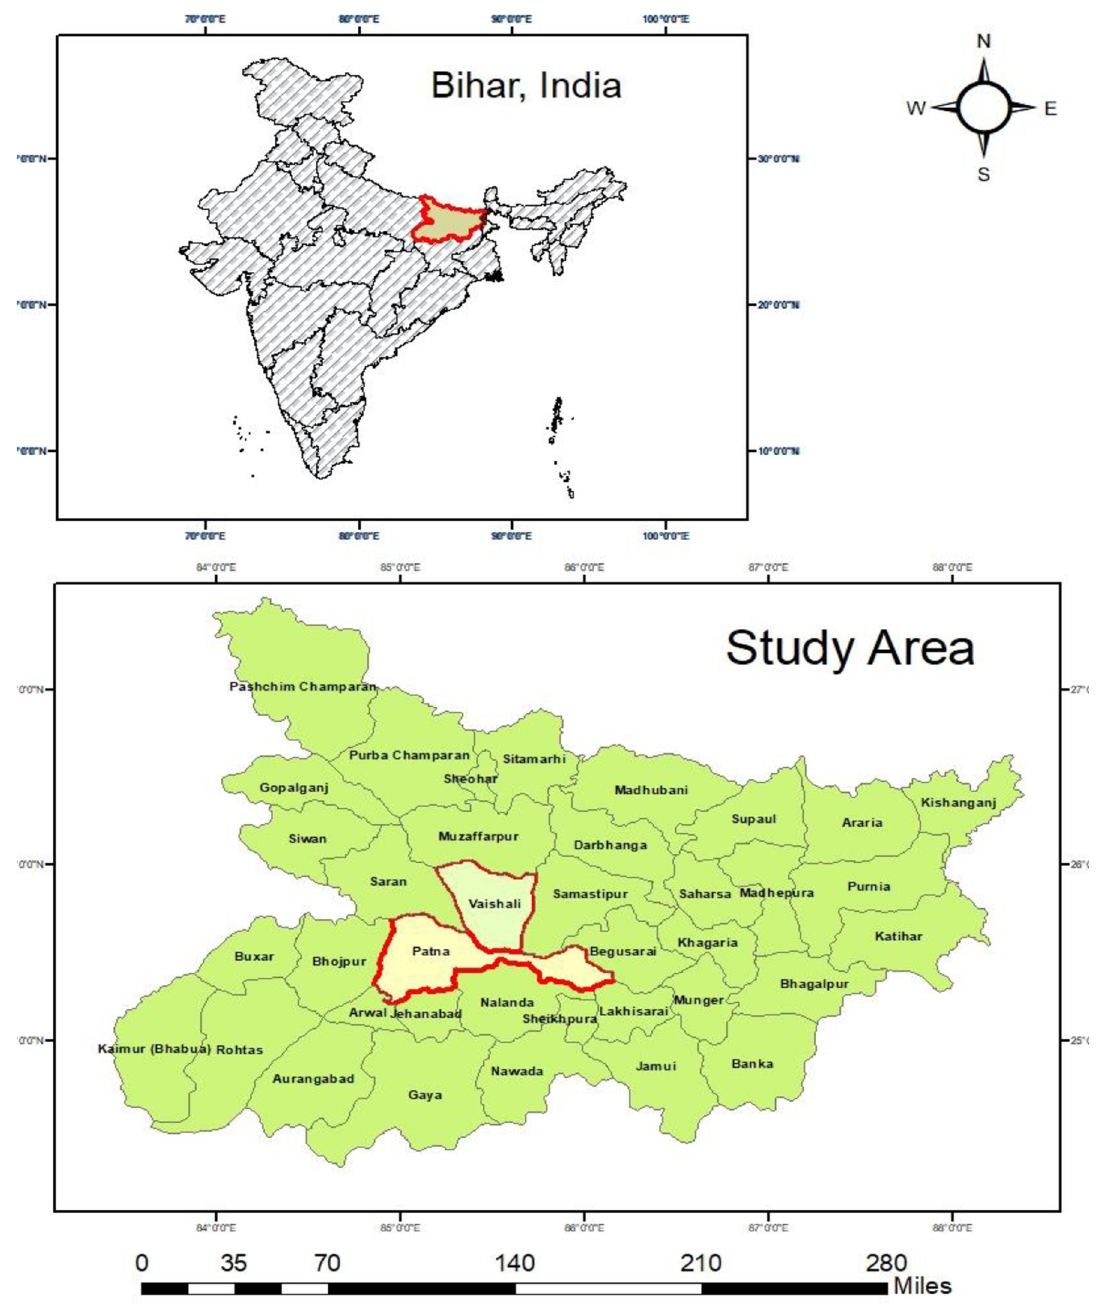
Fig 2. Study area. Source- Authors generated the map using